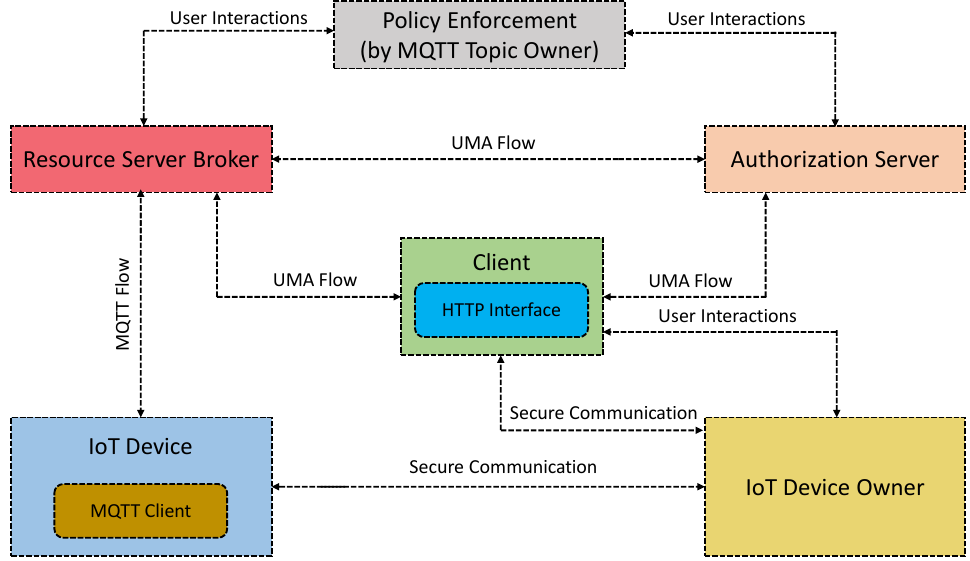
Figure 4. Information sharing with the different components of the ProBAC model presented in